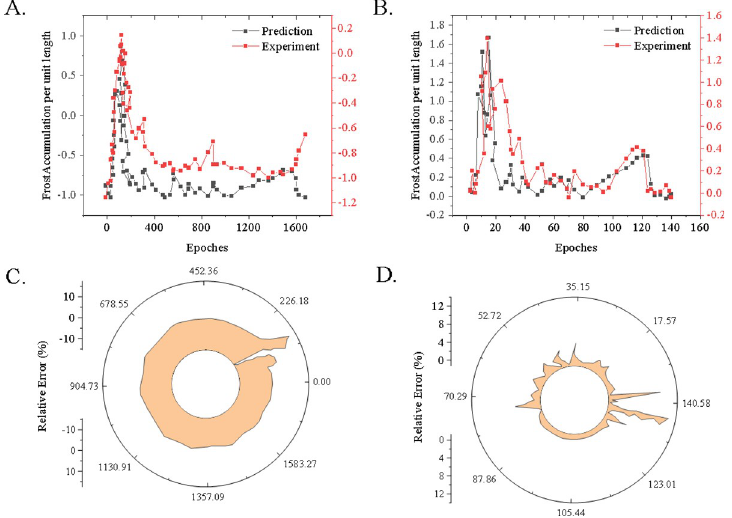
Fig 6. The training/verification performance and error